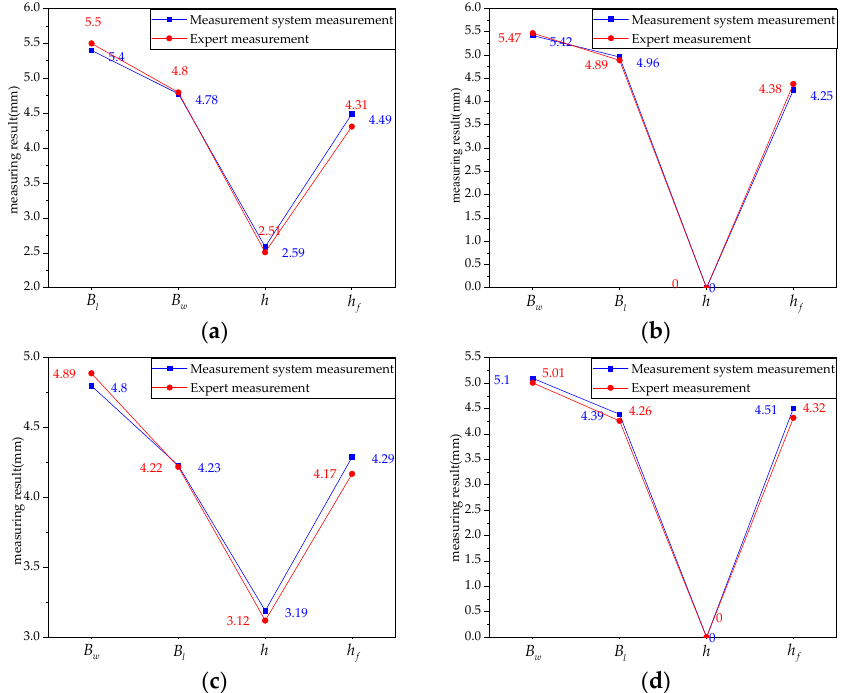
Figure 11. Key point detection visualization results: ( a ) the detection results of the model trained for 150 epochs; ( b ) the detection results of the model trained for 50 epochs.